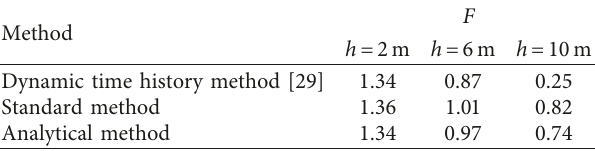
Table 1: Safety factor by different methods.